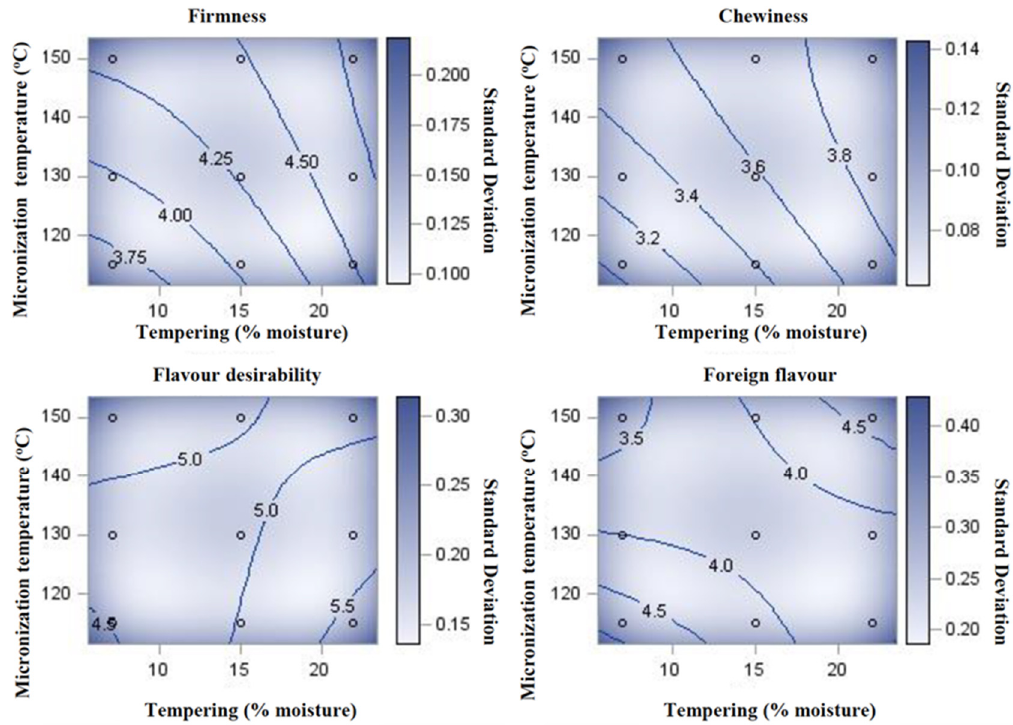
Figure 6. Contour plot for sensory firmness, chewiness, flavor desirability, and foreign flavor in bologna with added chickpea flour. Firmness: 5 = slightly firm, 4 = slightly soft, and 3 = moderately soft; chewiness: 4 = slightly easy to chew, 3 = moderately easy to chew; flavor desirability: 6 = moderately desirable, 5 = slightly desirable, and 4 = slightly undesirable; foreign flavor: 5 = slightly intense, 4 = slightly weak, and 3 = moderately weak. (Reprinted with permission from Unatrakarn [106]).